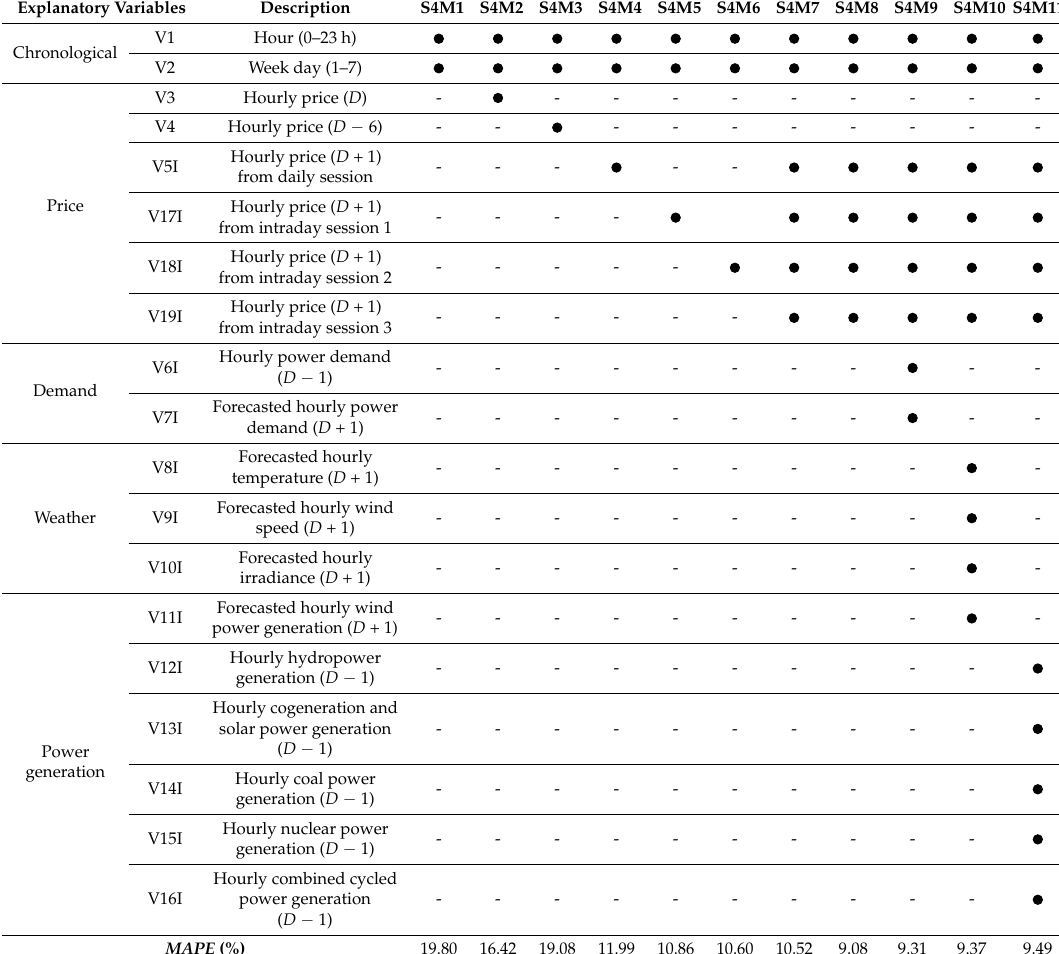
Table 11. ISMPF models for intraday session 4 and their MAPEs .